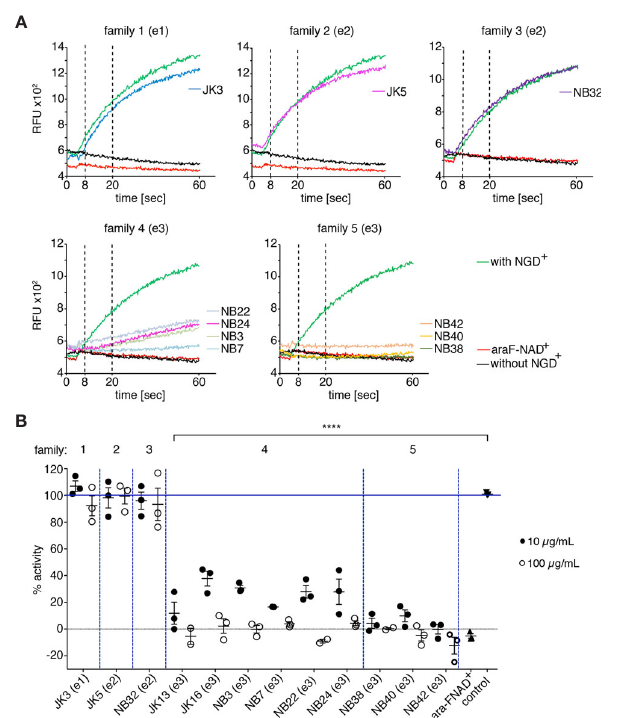
FIGURE 2 | hcAbs of families 4 and 5 inhibit the GDPR-cyclase activity of mouse CD38. EL4 thymoma cells were incubated with the indicated hcAbs or 10 m M araF-NAD + for 15 min at 37°C before fl uorescence measurements with a microplate reader. After the fi rst 20 cycles, 50 m M NGD + was added and kinetic